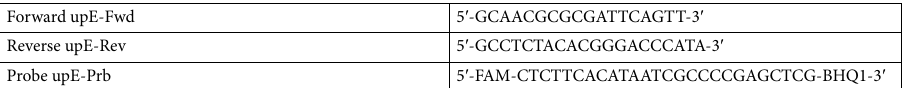
(Table 1). GAPDH was used as the reference gene. Measurements and analysis were performed with the Applied Biosystems™ 7500 Fast Dx Real-Time PCR Systems and associated software (Applied Biosystems). Relative gene expression was calculated using the 2 ΔΔCt method 28 . Data are shown as fold induction of IFN-treated samples compared to those of untreated controls. To examine the influence of IFN pretreatment on MERS-CoV infection in camelid AEC cultures, the cells were pretreated with type I and III IFNs (100 IU/ml and 100 ng/ml, respectively) 18 h prior to MERS-CoV infection at 37 °C. The basolateral medium containing type I or type III IFN was removed and replaced with medium without exogenous IFN before infection. Untreated Bactrian camel and llama AEC cultures were used as controls. Progeny virus released on the apical sides was collected with 100 µl of HBSS at 48 hpi.